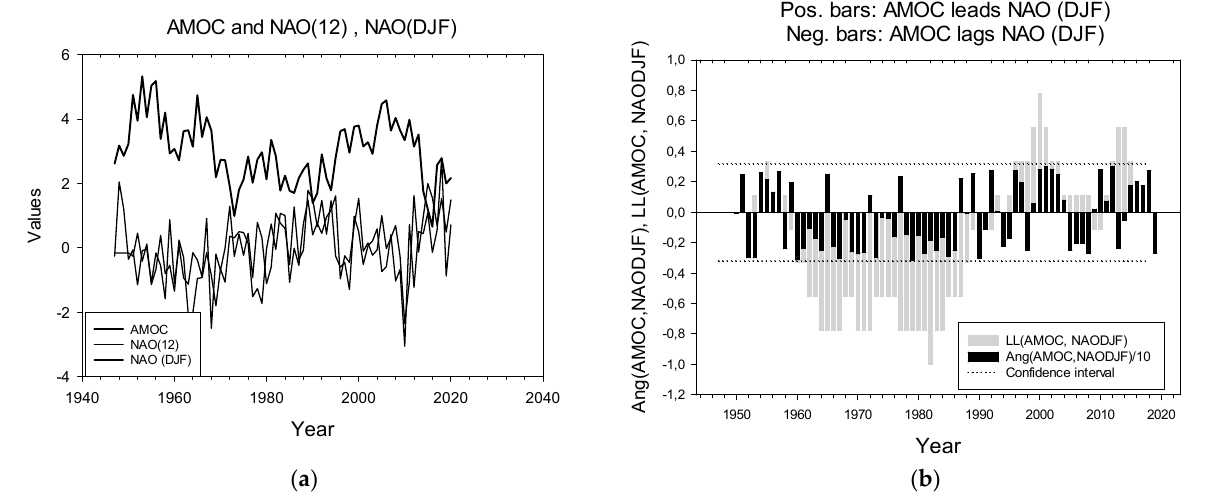
Figure A2. LL relations between AMOC and NAO (DJF). ( a ) Time series for AMOC and NAO (all months) and only the winter months (D, J, F); ( b ) LL relations. Note that the black bars are divided with 10 and are thus almost all significant. The period where AMOC lags NAO is from 1961 to 1988.